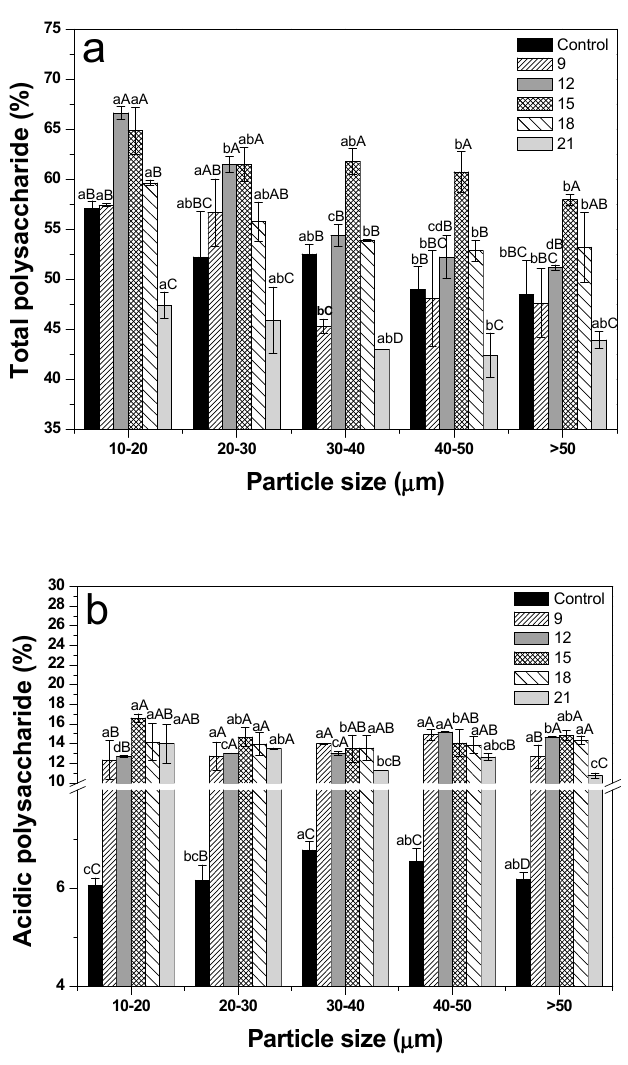
Figure 7. Polysaccharides of dried ginseng powders with di ff erent particle size according to roasting time. ( a ) Total polysaccharide; ( b ) acidic polysaccharide. After cryogenic milling of ginseng samples with di ff erent conditions, the samples were classified by their particle sizes. One treatment condition in each size range was then selected, and samples selected by particle size were then roasted and pulverized by cryogenic milling. a–c Means with di ff erent superscripts within the same time group are significantly di ff erent ( p < 0.05; Duncan’s test). A–E Means with di ff erent superscripts within the same size group are significantly di ff erent ( p < 0.05; Duncan’s